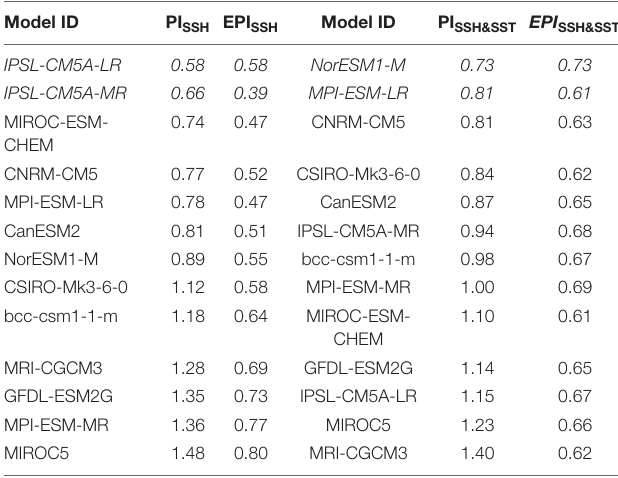
TABLE 1 | GCMs results based on PI SSH and PI SSH&SST (see Equations 2, 3, respectively).